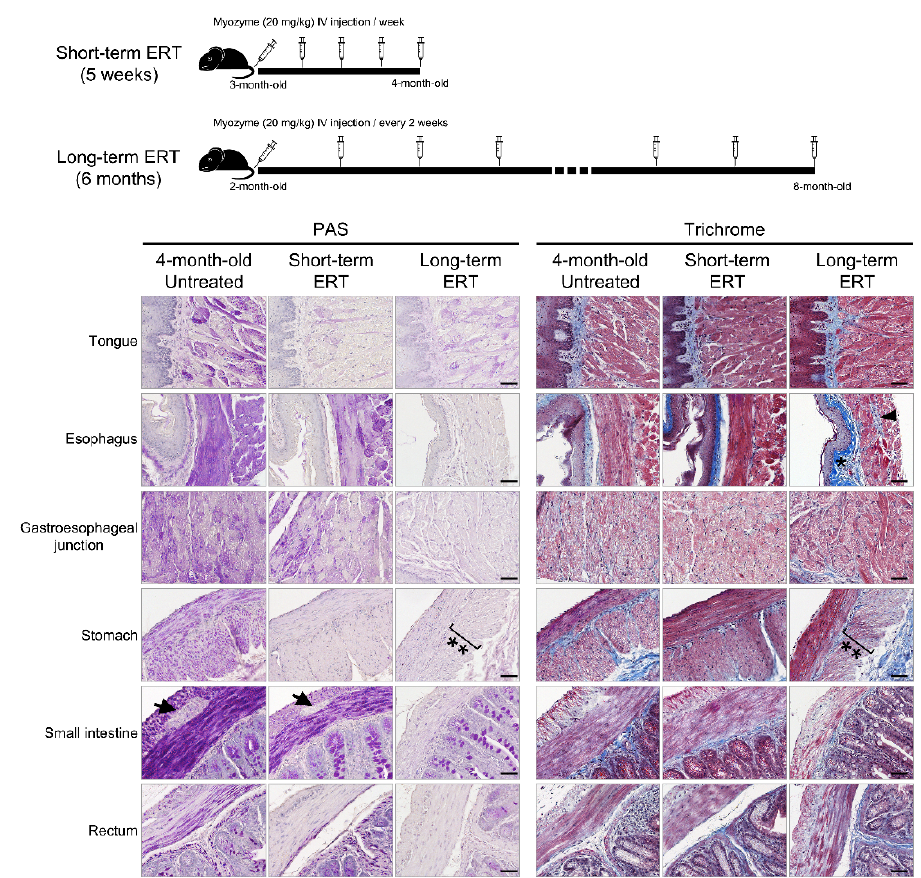
Figure 3. Short ‐ term and long ‐ term effects of ERT (alglucosidase alfa) on Pompe mice (GAAKO). ** Distorted muscularis externa layer in the stomach. * Fibrosis was noted in the 8 ‐ month ‐ old mice; however, this was also seen in the wild type mice. Aurbach’s plexus was seen in between the inner circular and outer longitudinal layers of the small intestine (arrows) and in the esophagus (arrow ‐ heads).